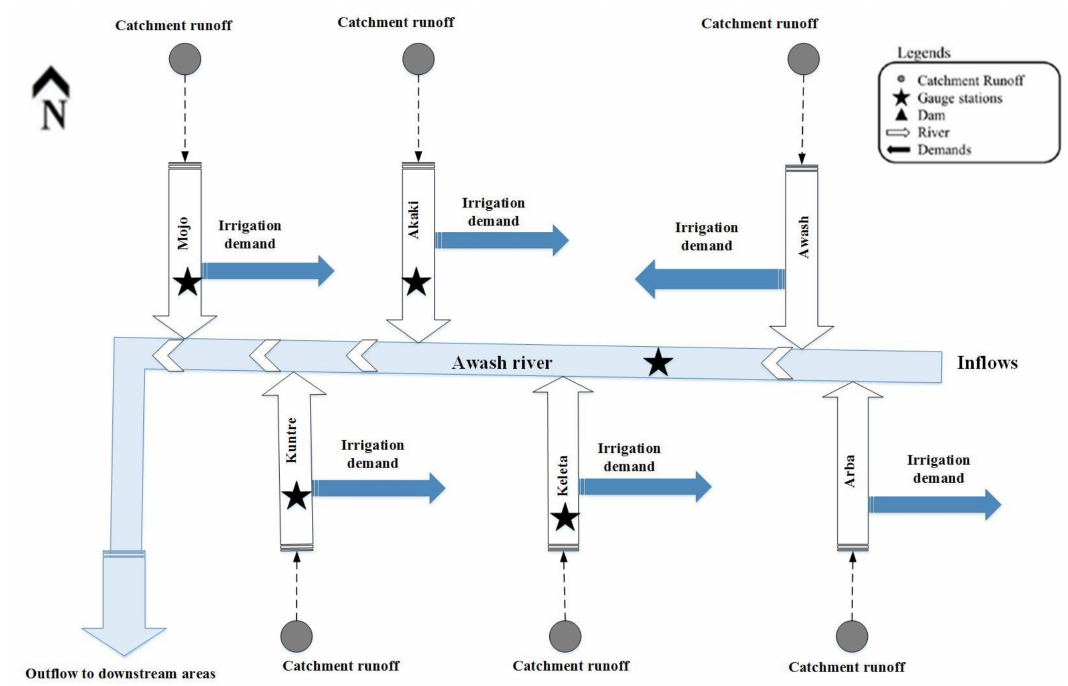
Figure 3. Water supply service structure and irrigation demands in the catchment.